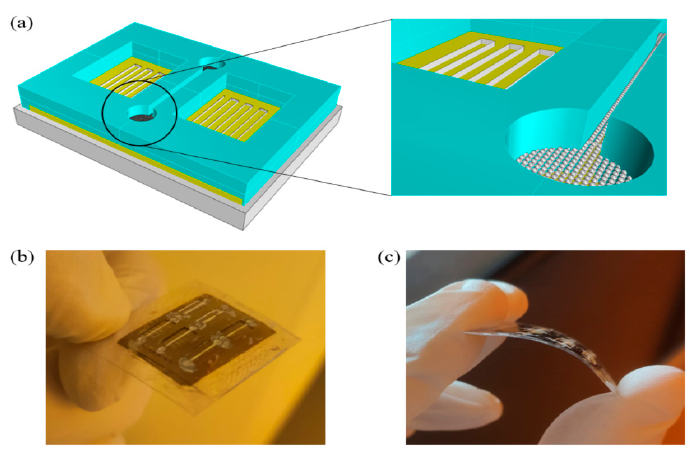
Figure 2. Tridimensional model of finished device ( a ); photo of the fabricated comformable PEN SAW-based device ( b , c ).